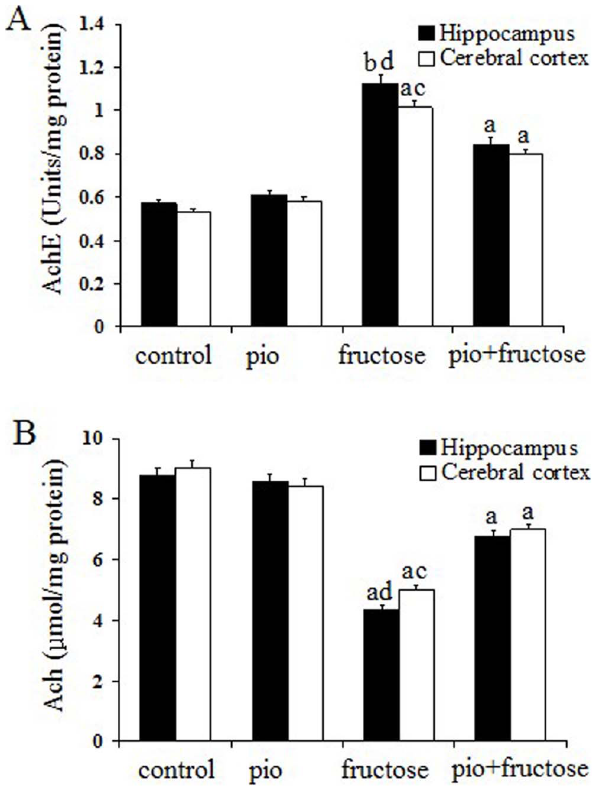
Figure 2. Effects of pioglitazone on AChE (A) and ACh (B) in the hippocampus and cerebral cortex of fructose-drinking insulin resistance rats. The control group (control) and the control treatment group (pio: pioglitazone) were treated with normal drinking water while the fructose group (fructose) and fructose treatment group (pio +- fructose: pioglitazone + fructose) were treated with 10% fructose solution for 16 weeks to develop insulin resistance. The fructose treatment group was orally administrated pioglitazone (10 mg/kg d) for the last 12 weeks of the 16-week period. Data are mean 6 SEM. Data are mean 6 SEM. The number of rats in groups control, pio, fructose and pio + fructose was 10, 9, 8, and 8, respectively. a P , 0.05, b P , 0.01 versus control group; c P , 0.05, d P , 0.01 versus untreated fructose-drinking group.